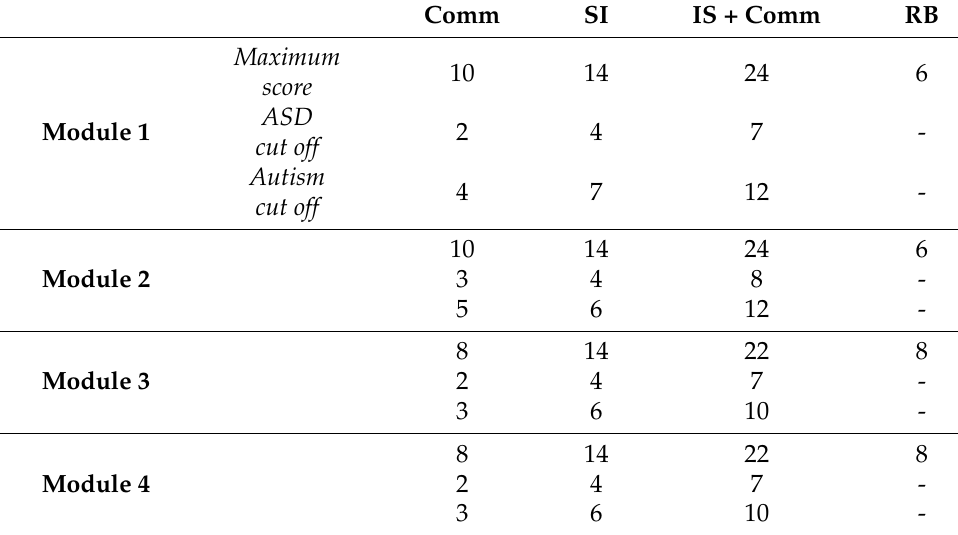
Table 2. ADOS maximum score and cut off points for ASD